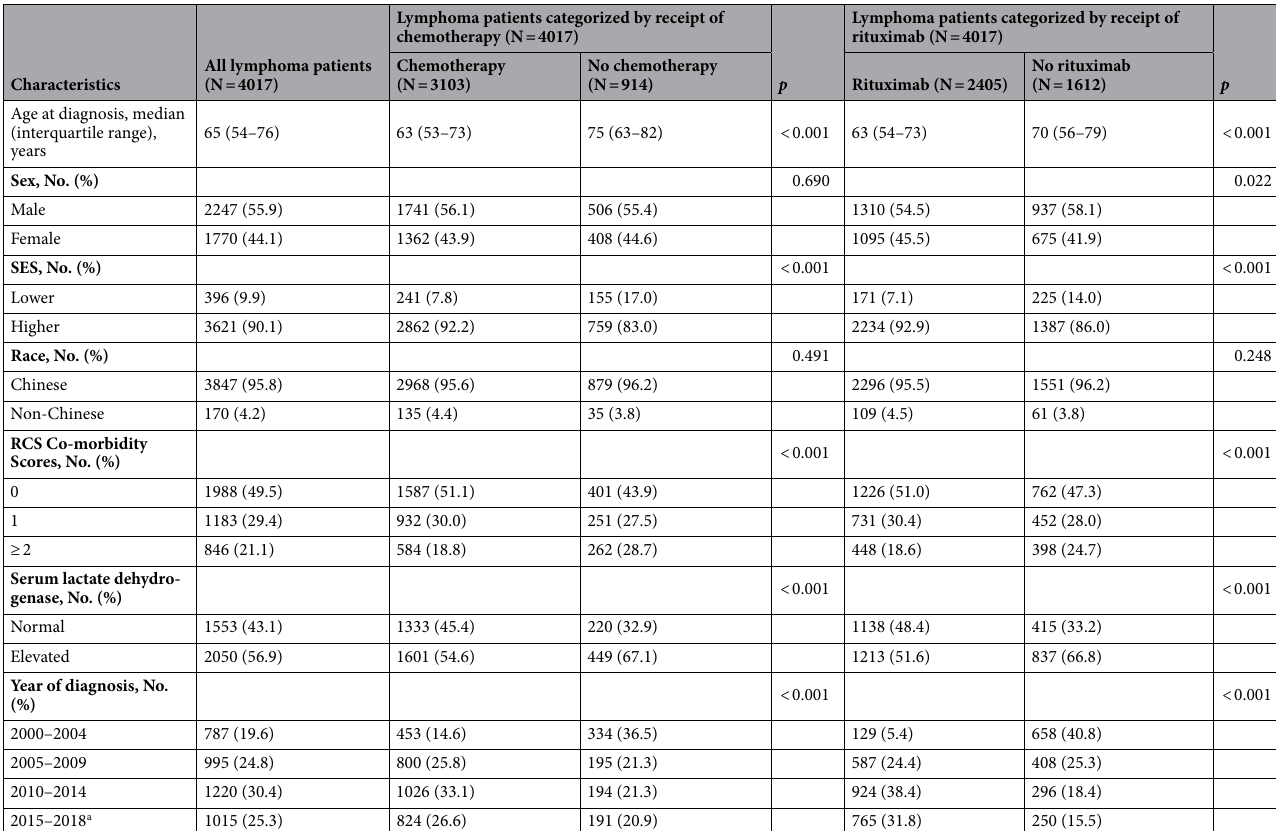
Table 1. Characteristics of diffuse large B-cell lymphoma patients, Hong Kong, 2000–2018 (N = 4017). RCS Royal College of Surgeons, SES socioeconomic status. a Four years only.